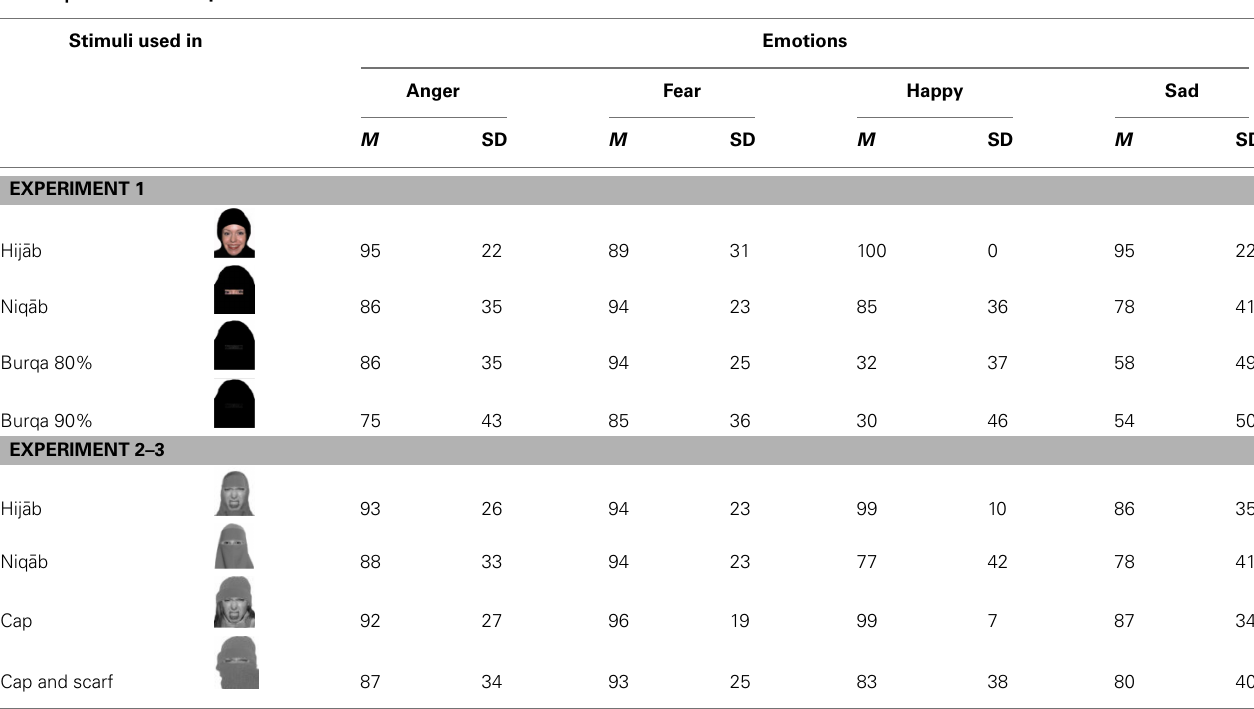
Table 1 | Stimulus examples and their